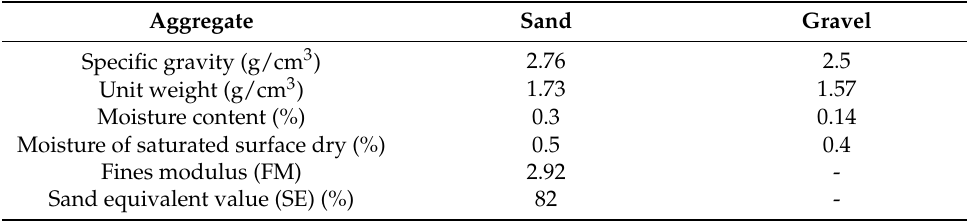
Table 1. Properties of natural aggregates.